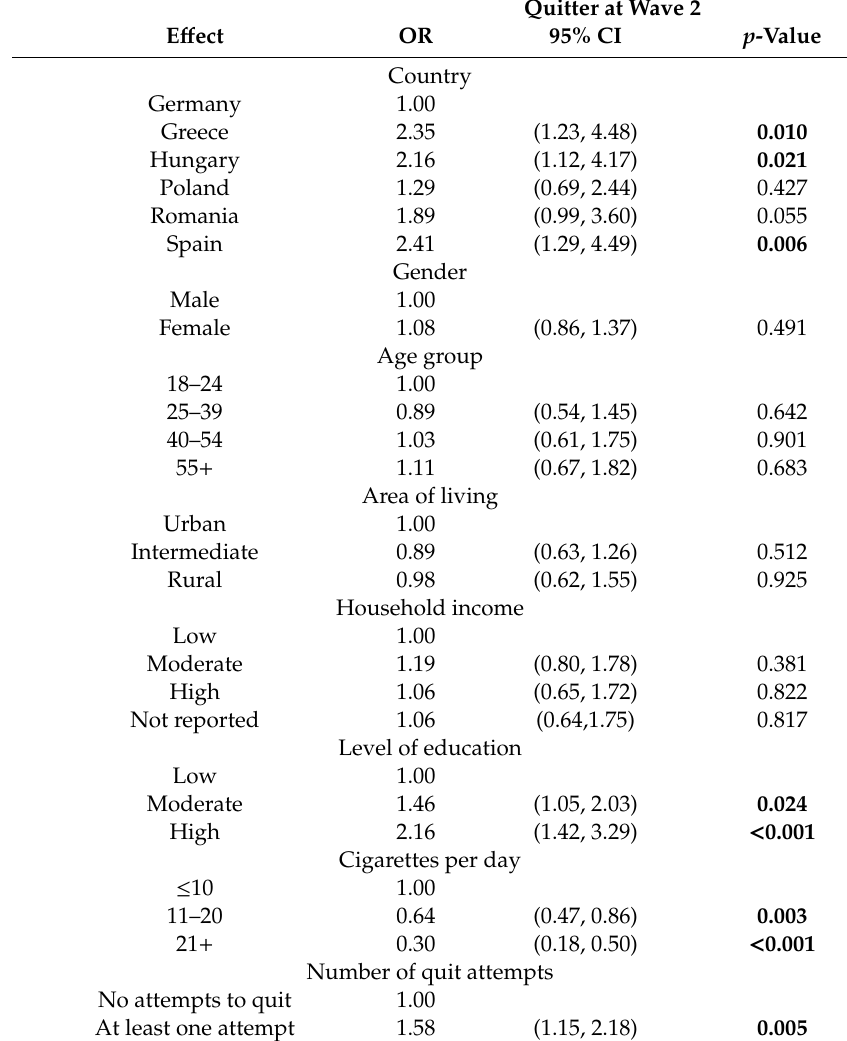
Table 3. Wave 1 factors associated with being a quitter at Wave 2 of the cohort sample ( n = 3100) of EUREST-PLUS ITC 6E Surveys. Quitter at Wave 2 E ff ect OR 95% CI p -Value